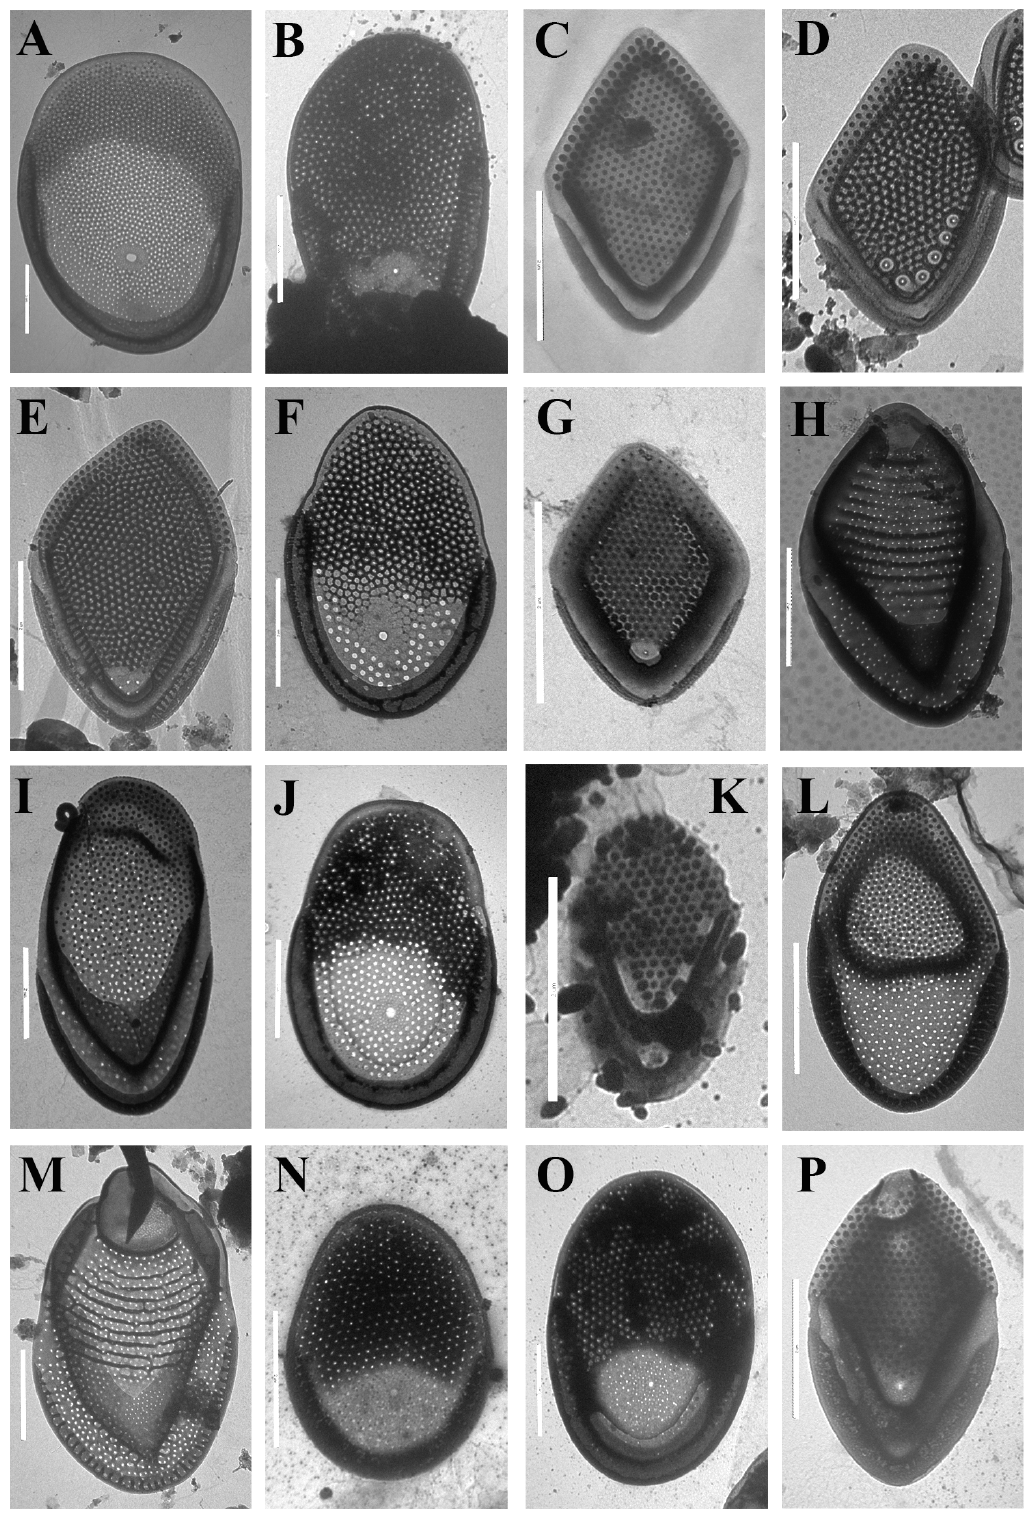
Figure 3. Mallomonas . ( A ). M. lamii . ( B ). M. loricata . ( C ). M. mangofera var. mangofera apud Dürrschmidt (1983). ( D ). M. mangofera var. foveata . ( E ). M. cf. mangofera var. reticulata . ( F ). M. matvienkoae var. siveri . ( G ). M. minuscula . ( H ). M. morrisonensis . ( I ). M. neoampla . ( J ). M. paragrandis . ( K ). M. parvula . ( L ). M. peronoides . ( M ). M. portae-ferreae . ( N ). M. pseudomatvienkoae . ( O ). Mallomonas sp. 6. ( P ). M. rasilis . Scale bars: 2 μ m. TEM: ( A – P ).